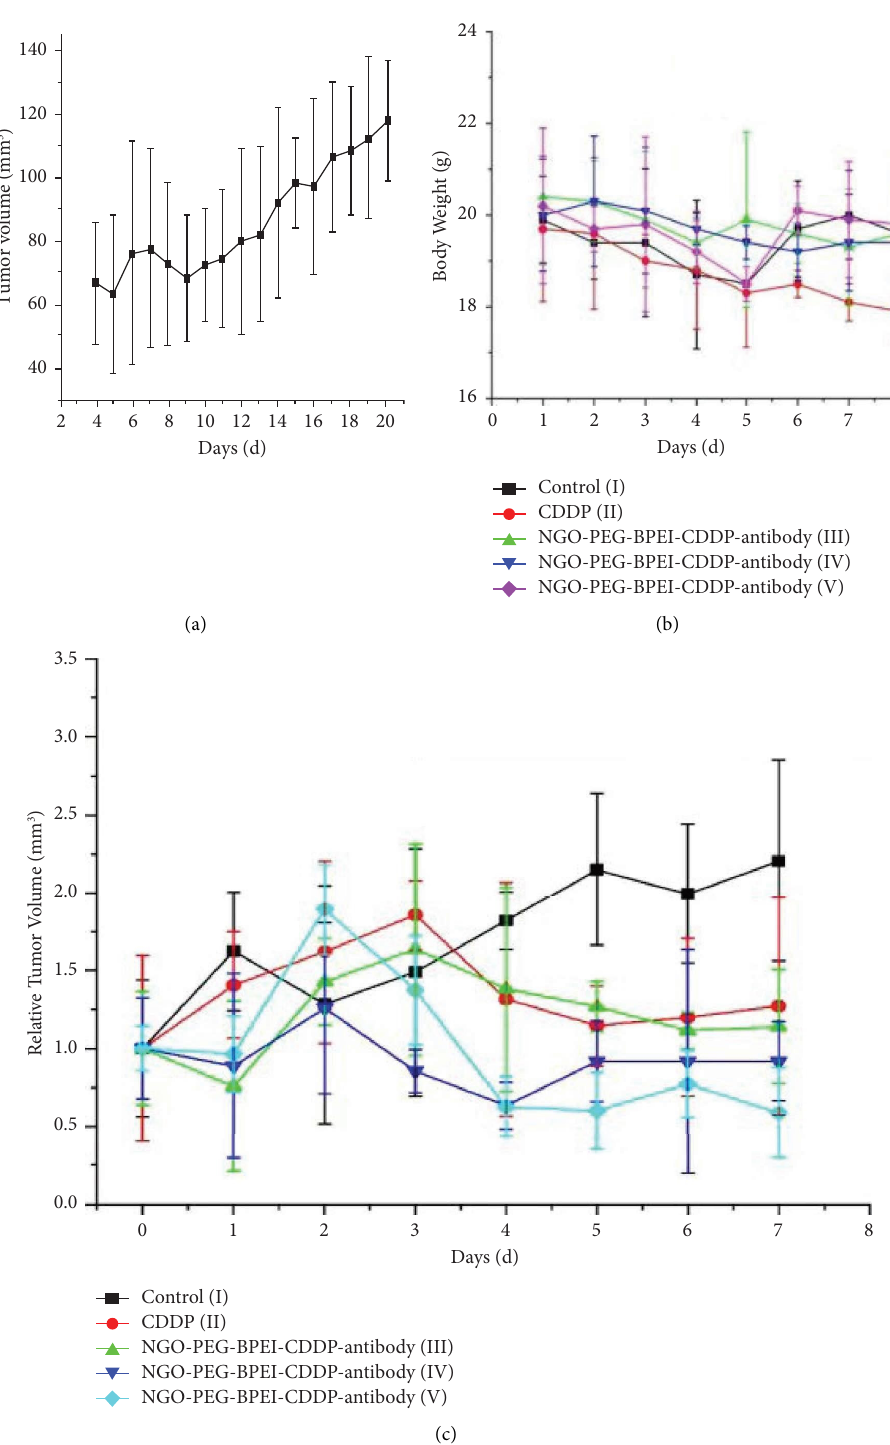
Figure 6: Te tumor volume-time growth curve of nude mice. (a) Tumor growth curve in nude mice; (b) weight change in nude mice; (c) tumor volume change after administration. Group I: control; group II: CDDP; group III: NGO-PEG-BPEI-CDDP-Antibody (100 μ g/one); group IV: NGO-PEG-BPEI-CDDP-Antibody (200 μ g/one); group V: NGO-PEG-BPEI-CDDP-Antibody (300 μ